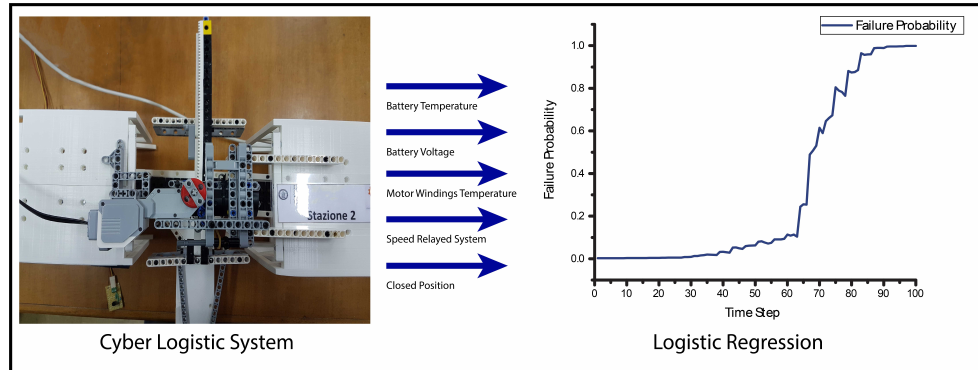
Figure 3. The generated degradation assessment model for our prototype.